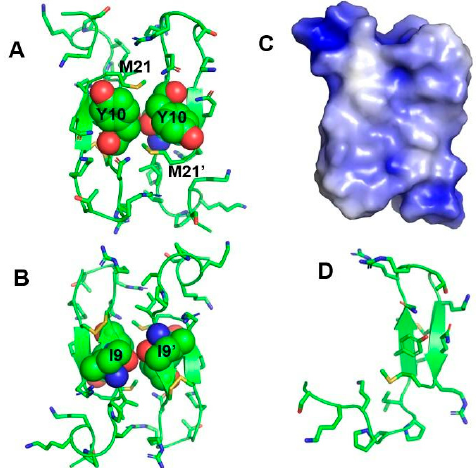
Figure 2. Structures of thanatin in lipopolysaccharide (LPS, pdb:5xo9) and dodecyl phosphocholine (DPC) (pdb: 6aab) micelles. Thanatin forms a dimeric structure in LPS micelles. The side chains of ( A ) Y10/Y10 ′ , M21/M21 ′ , and ( B ) I9/I9 ′ demonstrated packing interactions in the antiparallel β -sheet topology. ( C ) Electrostatic potential surface of dimeric thanatin. ( D ) Monomeric β -hairpin structure of thanatin in DPC micelles. The β -sheet is shown as a ribbon. The figure was prepared using PyMOL.